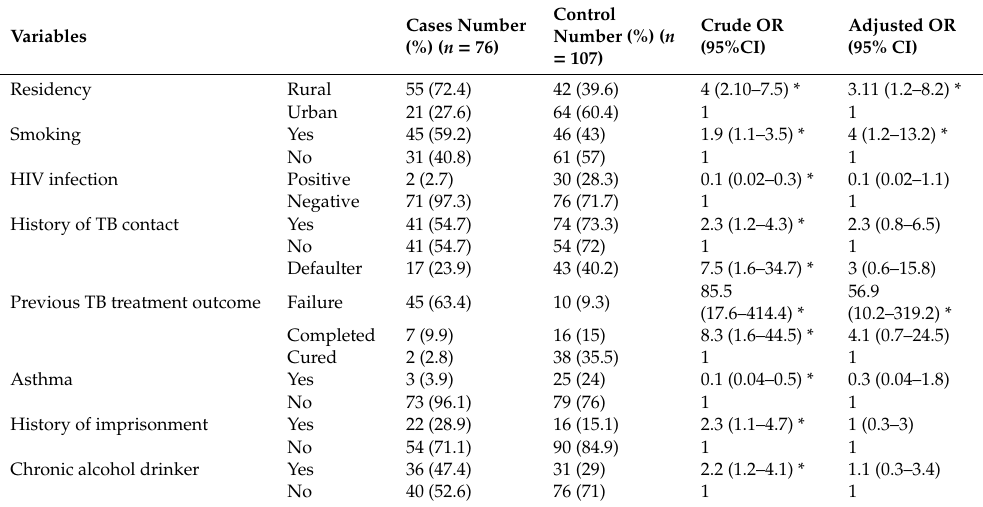
Table 4. Predictors of MDR-TB among resistant